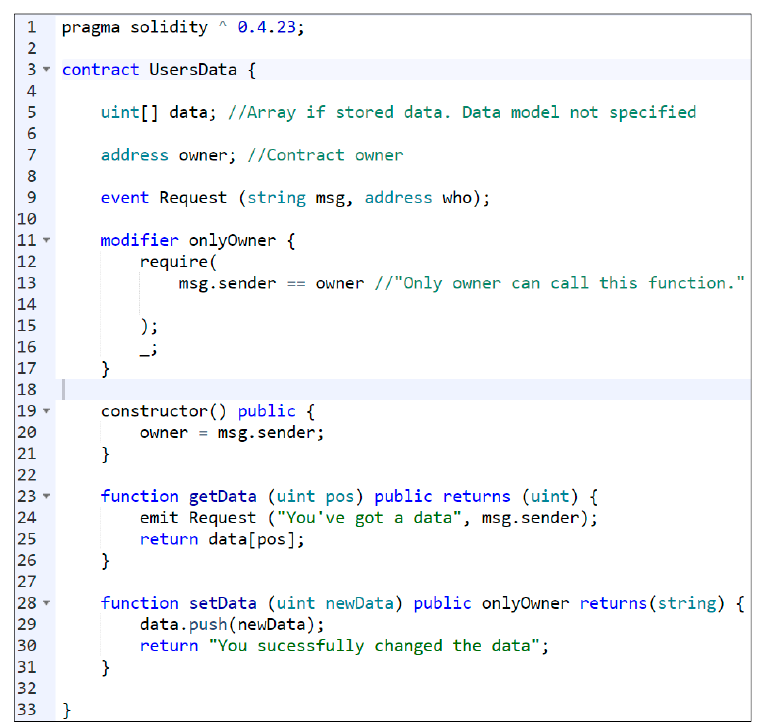
Figure 2. Smart contract for data